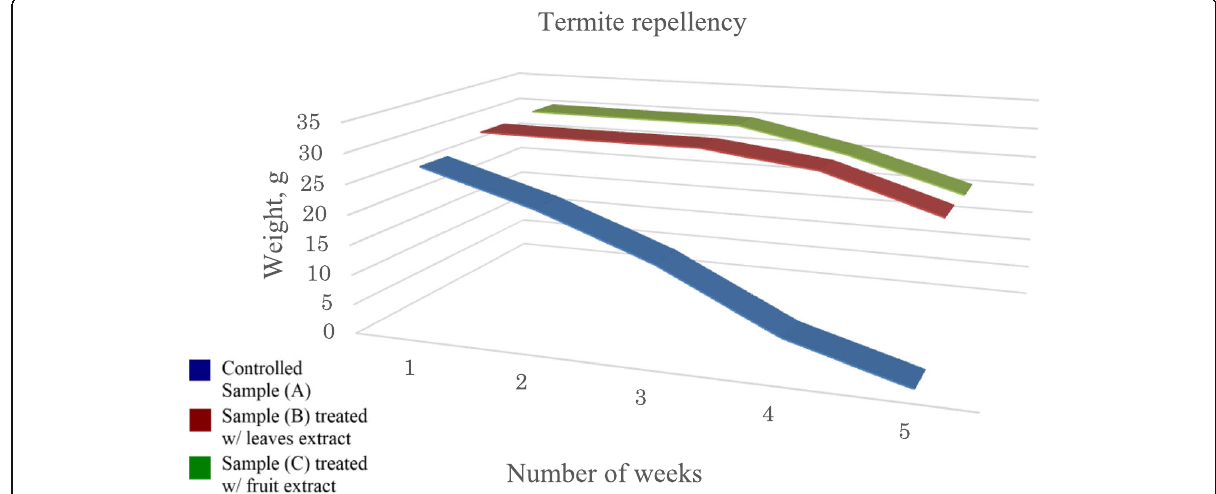
Fig. 8 Reduction in weight of wood samples subjected to termite repellency